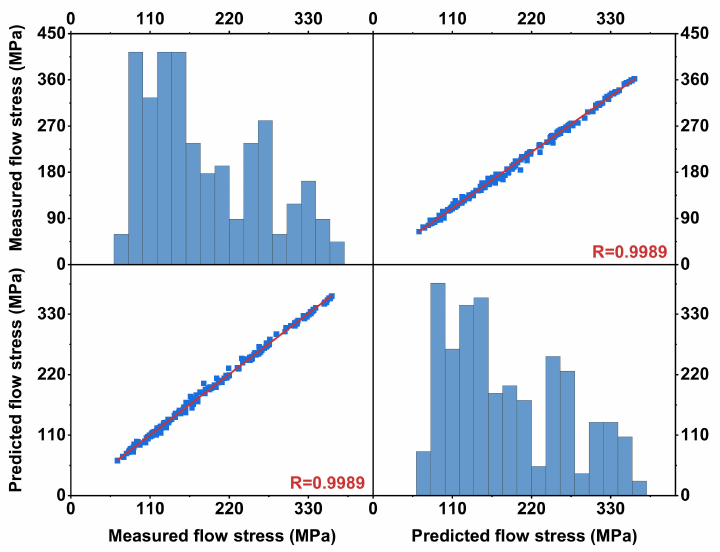
Figure 9. The bar chart and scatter map of the predicted and measured flow stress under all deforma- tion